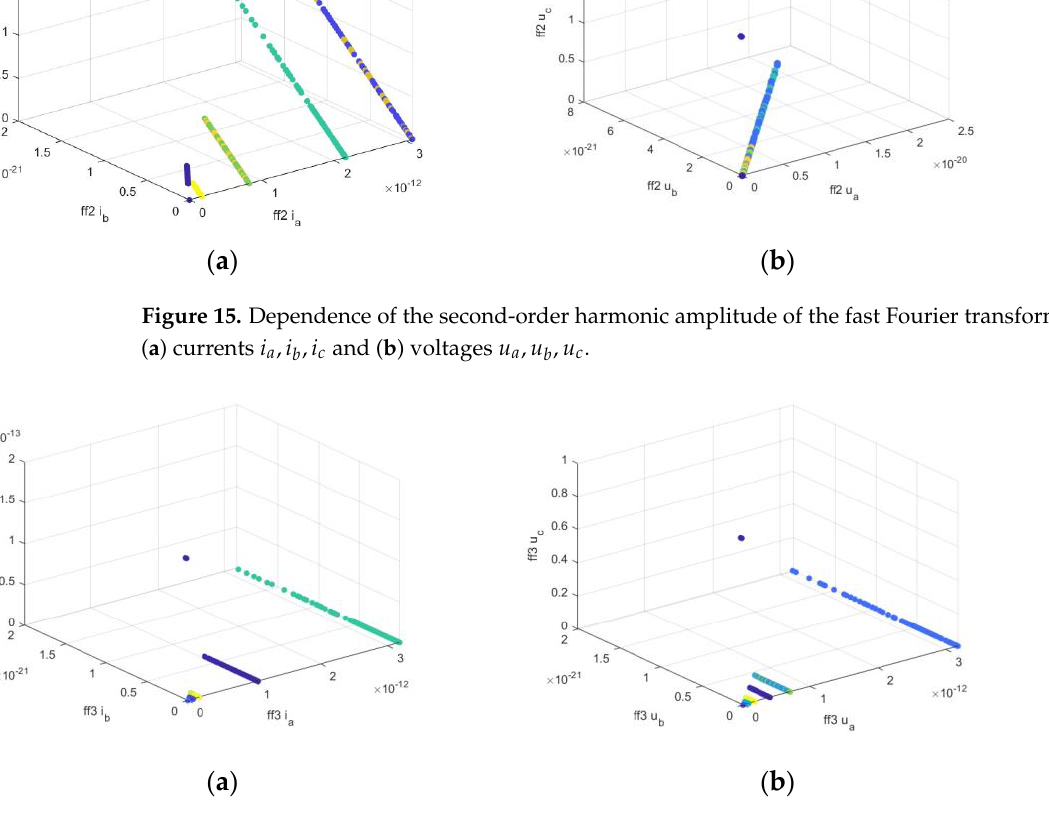
Table 1. Color assignments of the characteristics shown in Figures 9 – 16 .